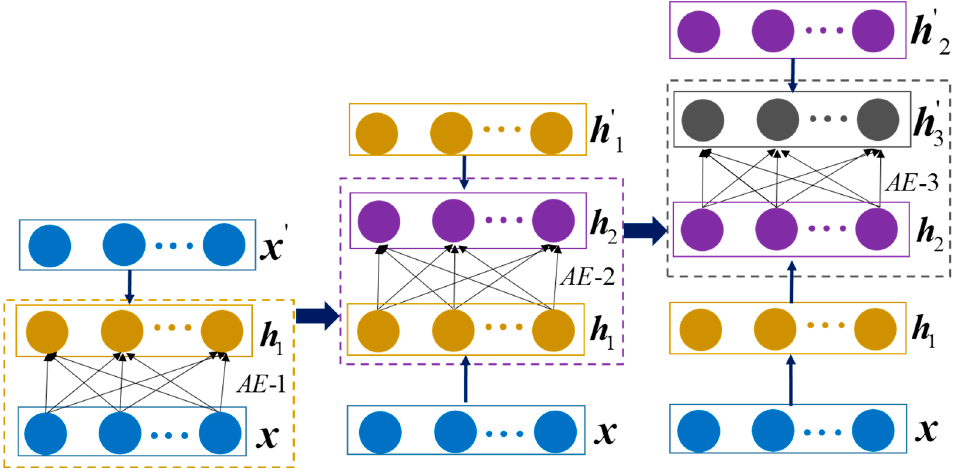
Figure 3. Three-layer stacked auto-encoder.